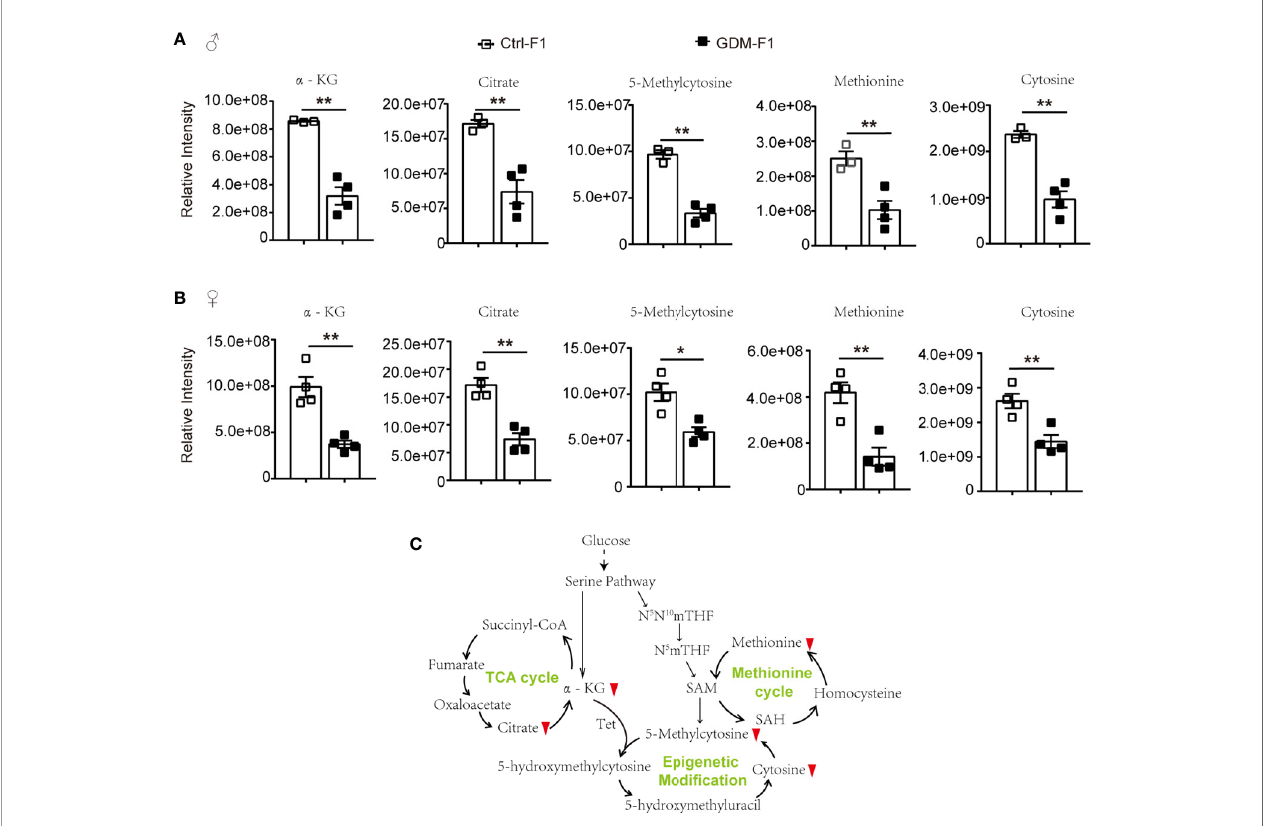
FIGURE 5 | The epigenetic modi fi cation related pathways and metabolites in GDM fetal pancreas. (A) Comparison of the representative intensity of metabolites related to the epigenetic modi fi cation pathway between GDM and Ctrl male fetus group. (B) Comparison of the representative intensity of metabolites related to the epigenetic modi fi cation pathway between GDM and Ctrl female fetus group. (C) The epigenetic modi fi cation related pathways in response to intrauterine hyperglycemia. The upward or downward red arrows represent an increased or decreased level of metabolites in the GDM-F1 compared with Ctrl-F1. All data were expressed as mean ± S.D. * P < 0.05 vs . Ctrl-F1; ** P < 0.01 vs .